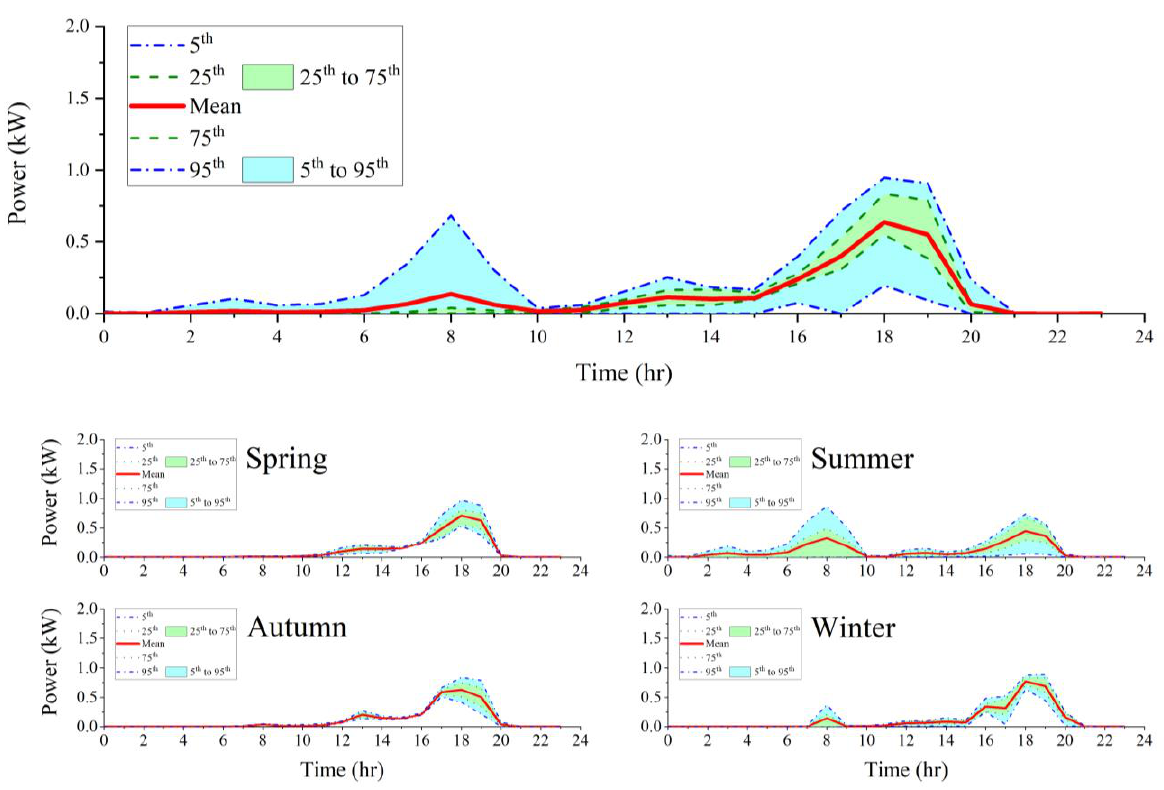
Figure 19. Average annual and seasonal posho mill daily load profiles (with percentile ranges).